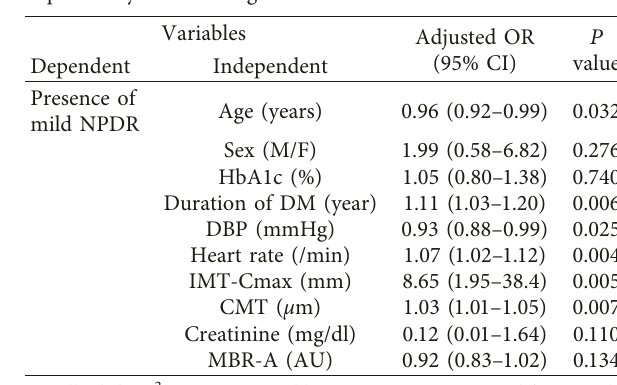
Figure 2: Relationship between IMT-Cmax and BOT. (a) BOT in the overall optic nerve head was negatively correlated with IMT-Cmax ( R � − 0 . 38, P < 0 . 001). (b) BOT in the optic nerve head tissue area was negatively correlated with IMT-Cmax ( R � − 0 . 34, P < 0 . 001). (c) BOT in the optic nerve head vascular area was negatively correlated with IMT-Cmax ( R � − 0 . 34, P < 0 . 001). Table 2: Multiple logistic regression analysis of factors in- dependently contributing to mild